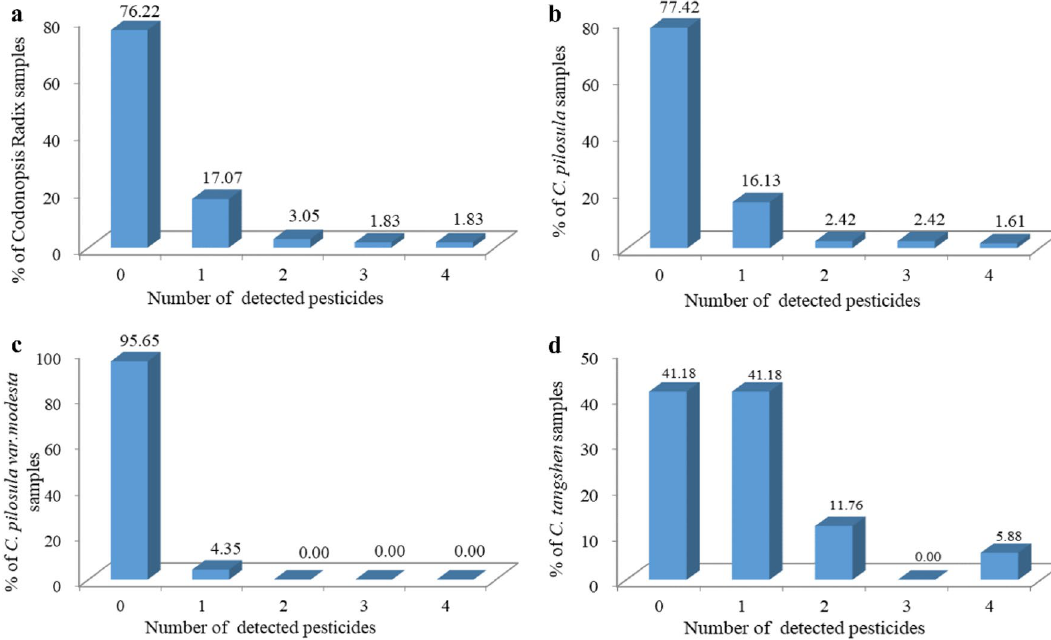
Figure 2. The number and proportion of pesticide residues detected in samples of CR ( a ), C. pilosula ( b ), C. pilosula var. modesta ( c ), and C. tangshen ( d ).